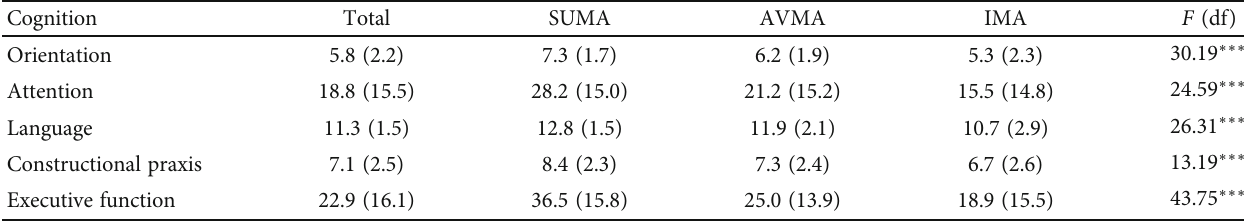
Table 2: Group comparisons on cognitive performance ( n = 590 ).